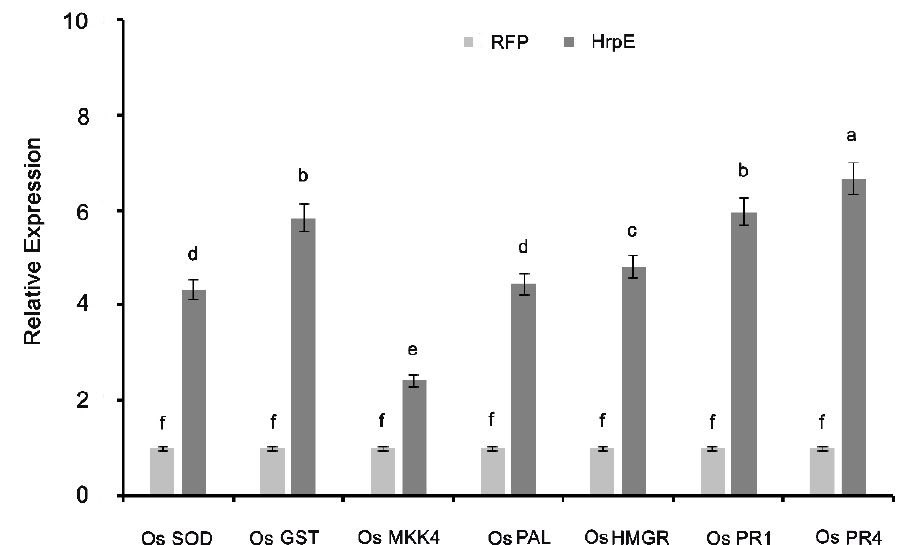
Figure 7. Expression profiling of the rice defense-related genes in the leaves infiltrated with HrpE by q RT-PCR. Values represent the average of three biological replicates with three technical replicates. Error bars signify standard deviations of the means. Di ff erent letters above the columns in the graph show a significant di ff erence among the treatments at p < 0.05. The experiment was repeated three times.